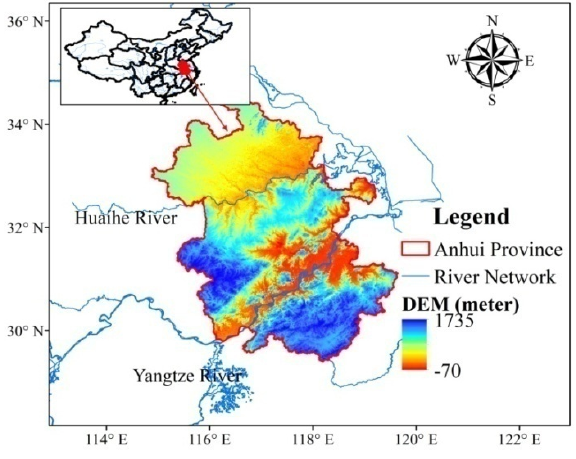
Figure 2. The location of Anhui province.